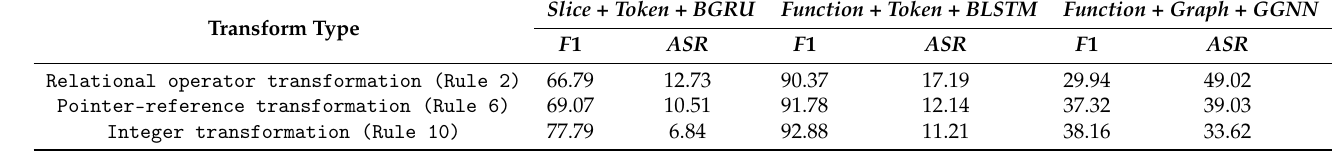
Table 6. Comparing the performance of attacks after removing the corresponding transformation rule (unit: